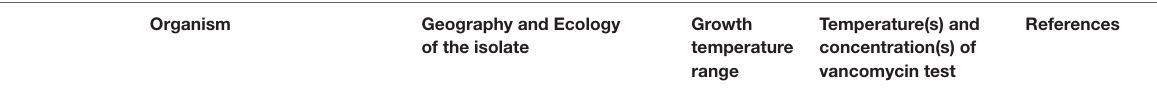
TABLE 4 | Gram negative thermophilic bacteria found to be susceptible to